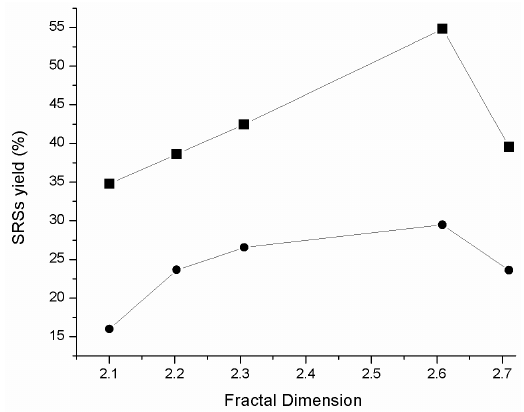
Figure 8. Catalytic activity (cellulose conversion) as a function of the fractal dimension of the cellulose surface. Hydrolysis catalysed by (- ● -) H 2 SO 4 and (- ■ -) H 3 PW 12 O 40 .